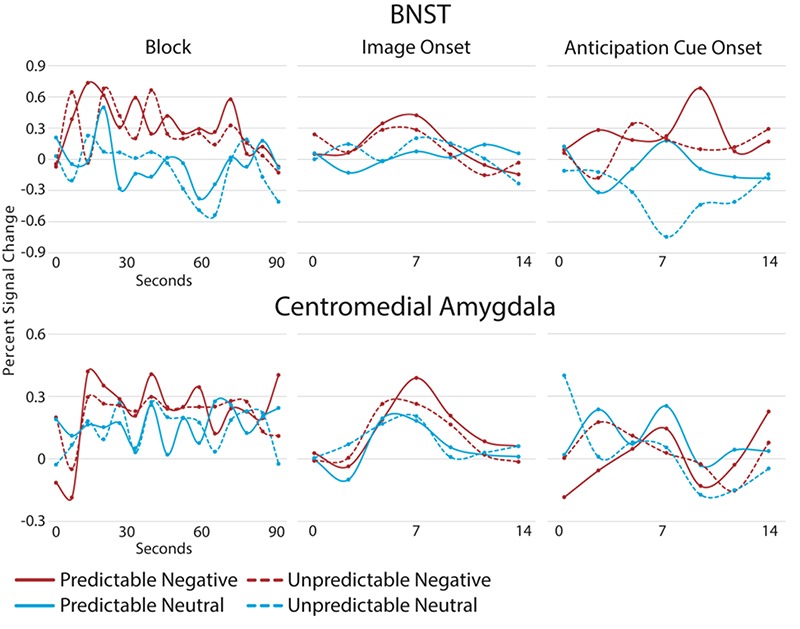
Mean BNST (top) and CM (bottom) BOLD time course during blocks (left), at image presentation (middle) and anticipation cue onset (right) by condition. Time courses were estimated with an AFNI tent function with 15 tent poles for blocks and 7 tent poles for image and anticipation cue onset (tent poles are represented by dots). Only trials with anticipation periods of at least 5 s were used in creating anticipation cue time courses.